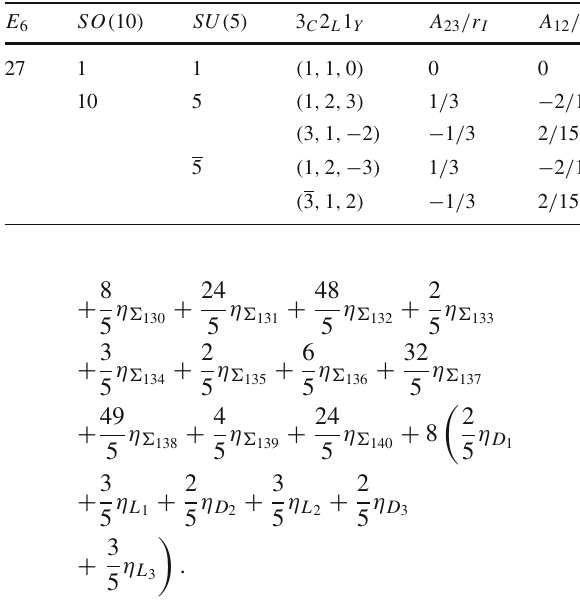
Table 7 Contributions of the exotic fermions in the fundamental 27- dimensional representation of E 6 to the ratio A 23 / A 12